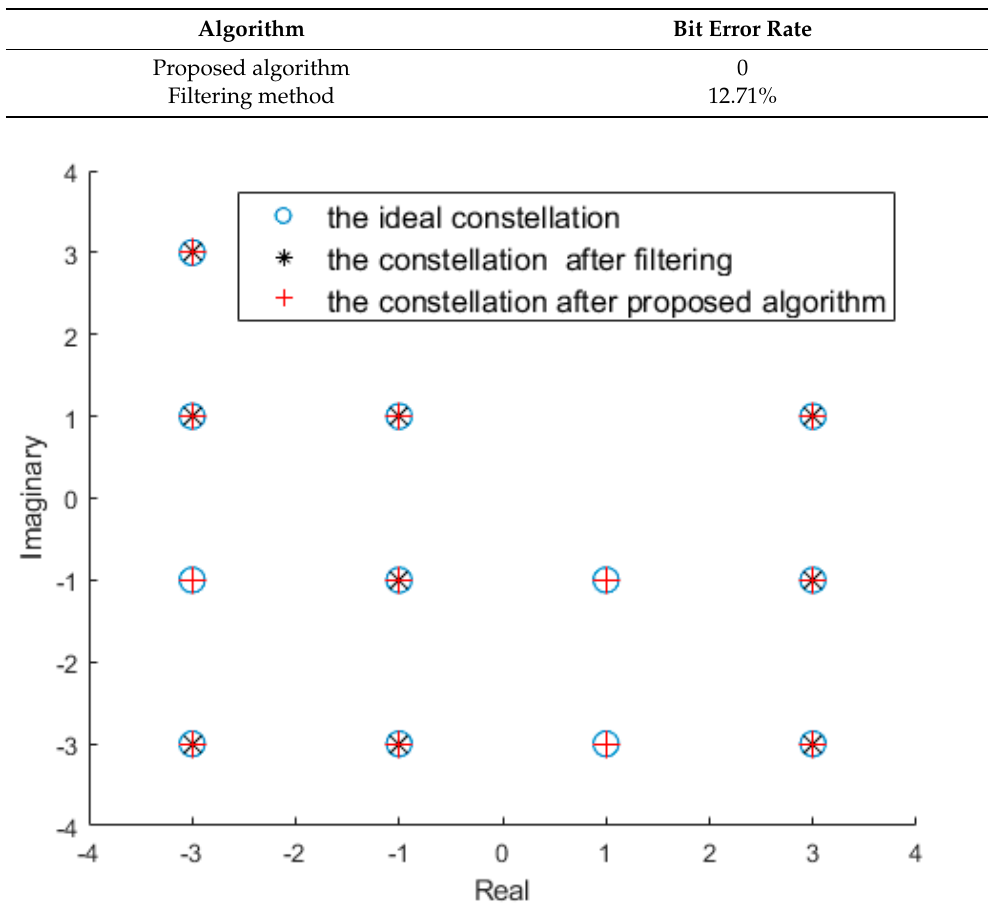
Figure 7. The results of the constellations of the ideal, proposed algorithm and filtering (weak wind).